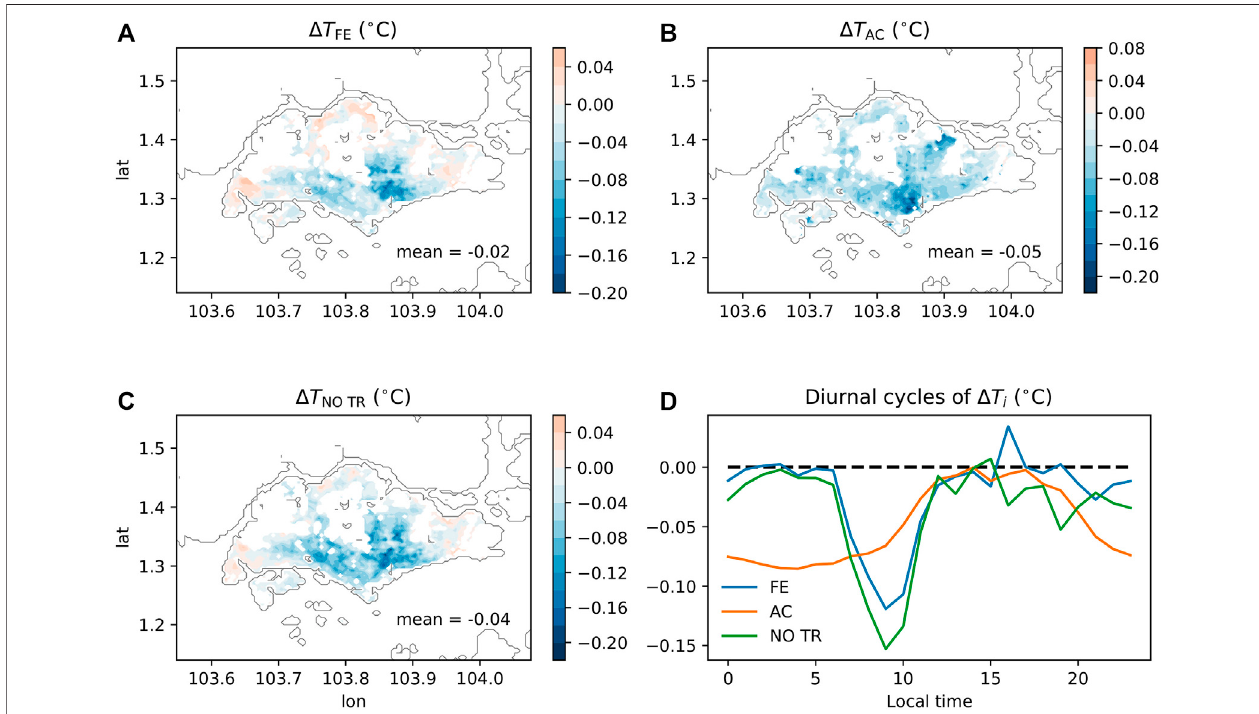
FIGURE 4 | The heat mitigation of FE is more localised than measures on AC, both temporally and spatially. (A) shows the period-average near-surface air temperature difference ( Δ T FE , ° C) due to a full fl eet electri fi cation, (B) shows the period-average Δ T FE due to an increase in 25% in centralised AC (AC), (C) shows the period-average Δ T FE in the case of no traf fi c (NO TR) and (D) shows the period-average diurnal cycle of Δ T FE for the different